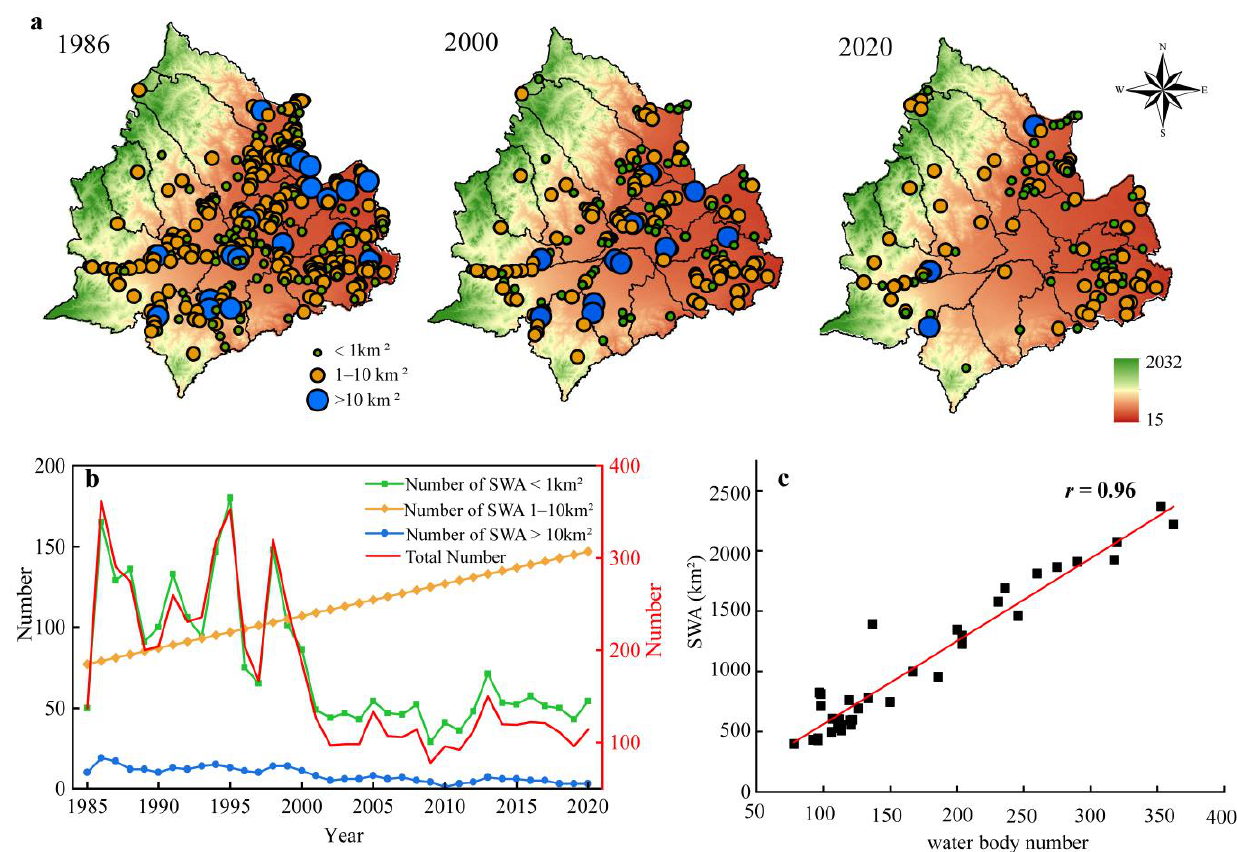
Figure 8. ( a ) Spatial distribution of different sizes of SWA on HQSL in 1986, 2000, and 2020. ( b ) The number of different sizes of SWA on HQSL from 1985 to 2020. The colors in ( a , b ) represent the area and number of SWA < 1 km 2 (green), 1–10 km 2 (orange), and >10 km 2 (blue) water bodies. ( c ) Correlation of area and number of surface water.